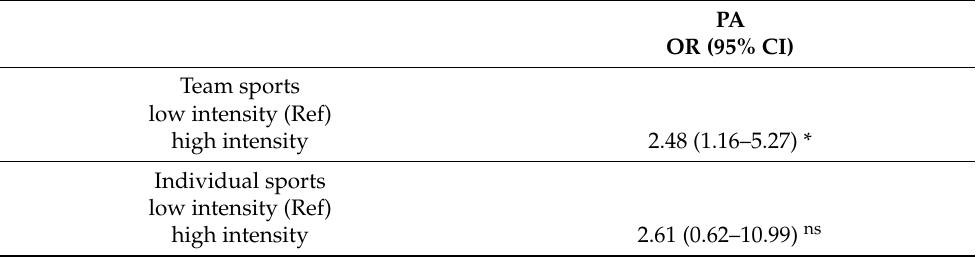
Table 5. Logistic regression model of physical activity level and activity type by intensity level.